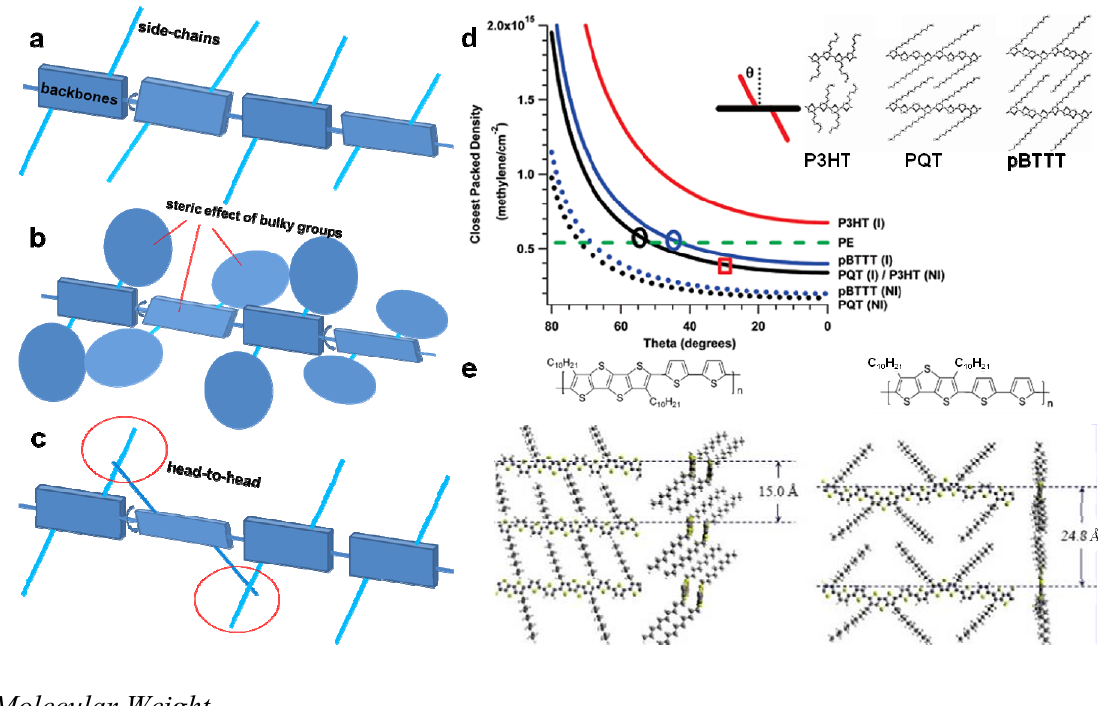
Figure 13. ( a – c ) Schematic illustration of side-chains on the inter-ring torsion in backbones; ( d ) the calculated side-chain packing density with varying tilting angle and the optimal stacking mode for P3HT, PQT and pBTTT, (Adapted with permission from [129]. Copyright 2007 American Chemical Society) and ( e ) the illustration for effect of side chain substitution position on the lamellar stacking mode, (Adapted with permission from [121]. Copyright 2009 American Chemical